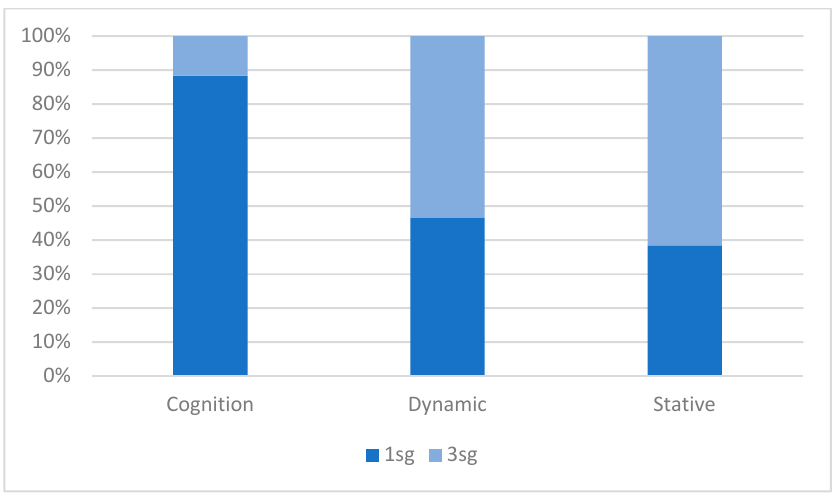
Figure 1. Predicted rate of subject expression for subject person by verb class, from model presented in Table 1. Pronominal subjects are favored most with 1sg vs. 3sg subjects and with cognition verbs.